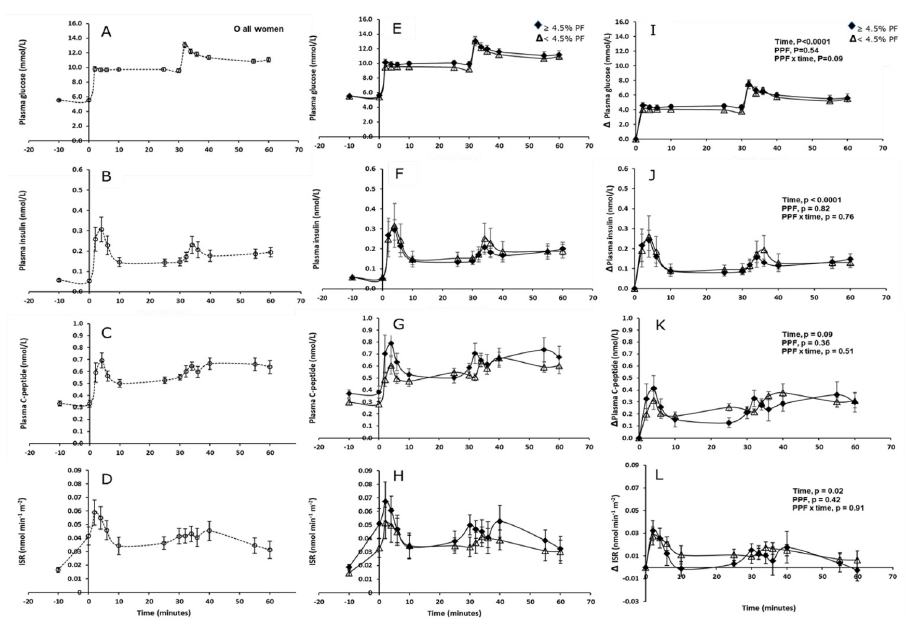
Fig 3. Time course (mean ± SEM) of blood biomarkers during each 30 minute square-wave hyperglycaemic step of the intravenous glucose tolerance test in all women (A-D—open circle, dash lines) in defined low and high percentage pancreatic fat (PPF) groups (E-H) and as change from baseline (I-L). MR-determined PPF groups are as follows: E-L; � 4.5% pancreatic fat–solid diamond, solid line, < 4.5% pancreatic fat–open triangle, solid line.